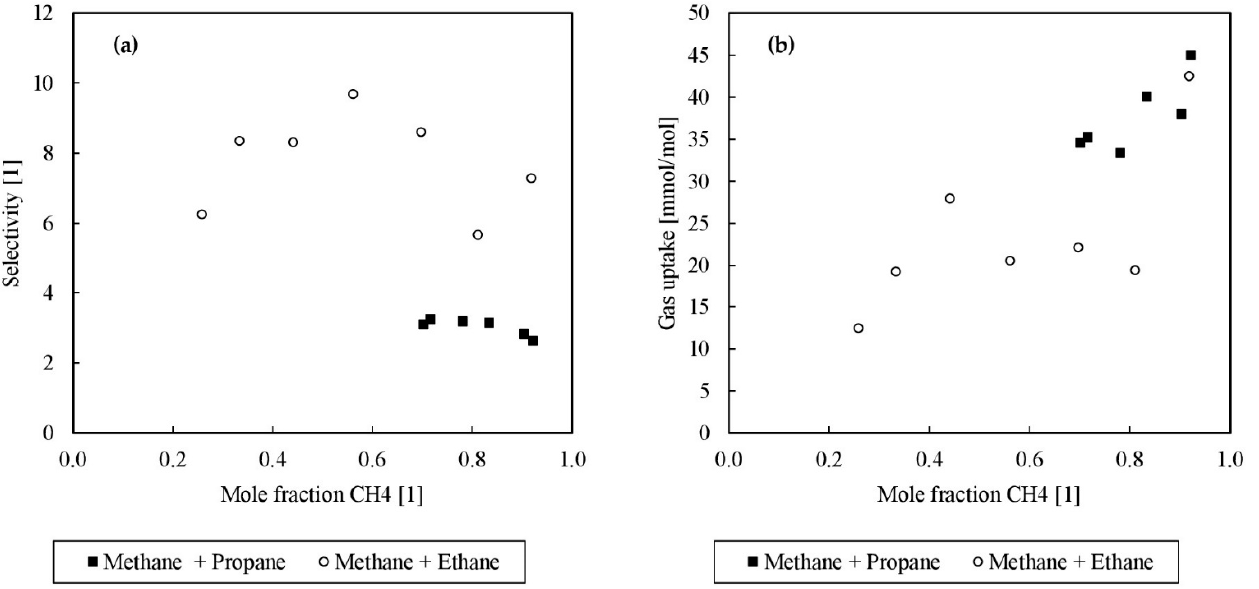
Figure 2. ( a ) Selectivity (ordinate) vs. initial mole fraction of methane (abscissa); ( b ) gas uptake in millimoles of gas per mole of water (ordinate) vs. initial mole fraction of methane (abscissa).